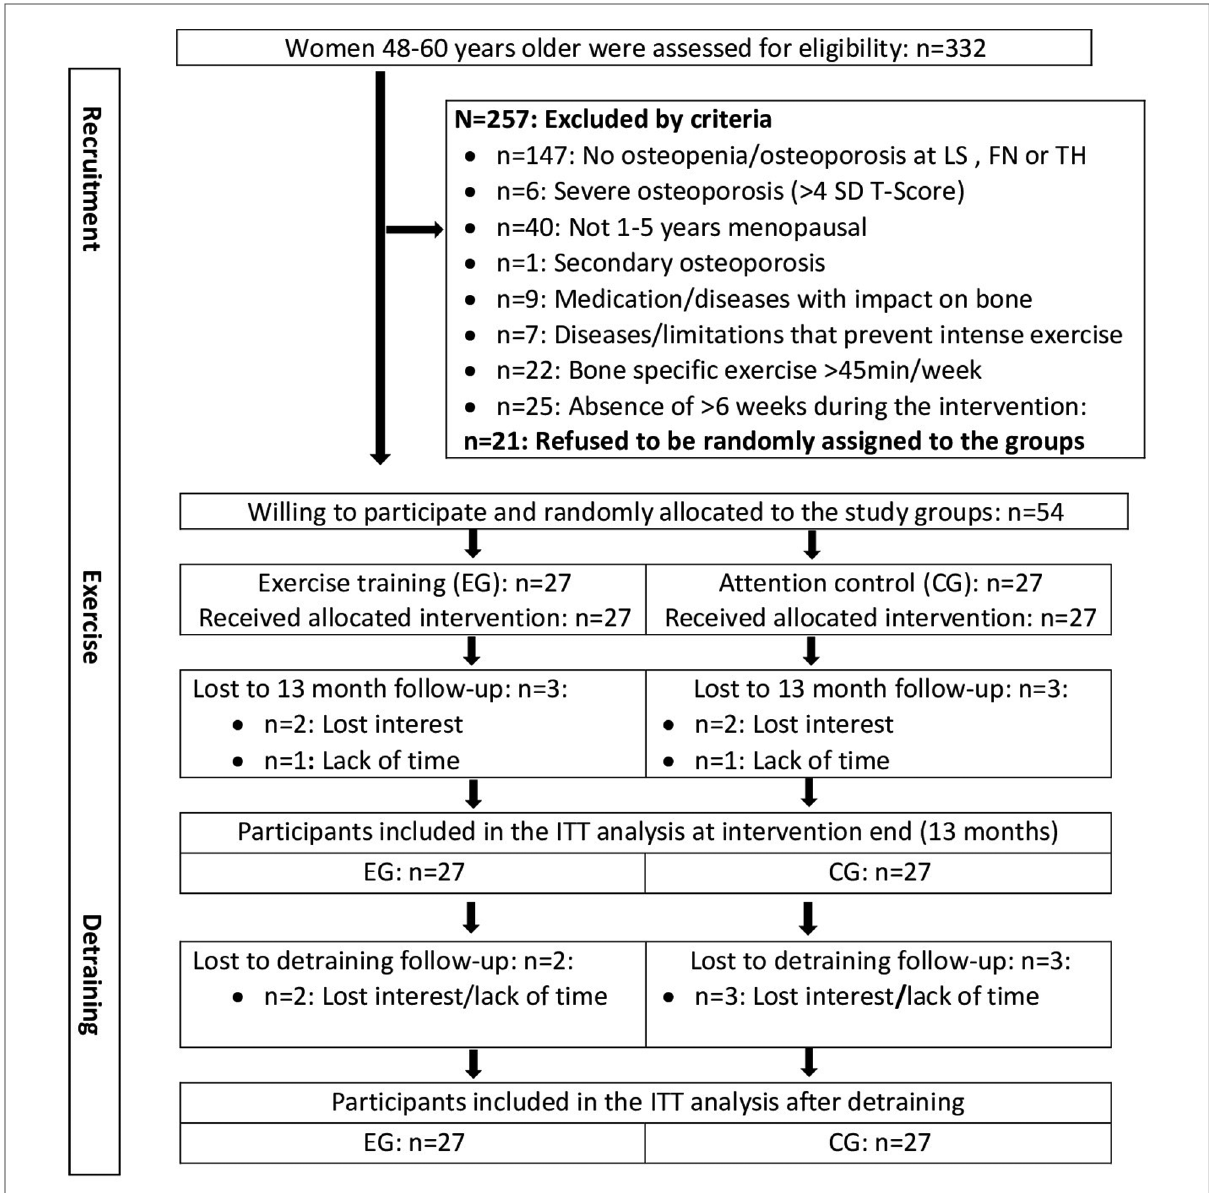
FIGURE 1 Flow chart of the study dedicated to participants with assessment of the MRS II questionnaire after intervention and detraining